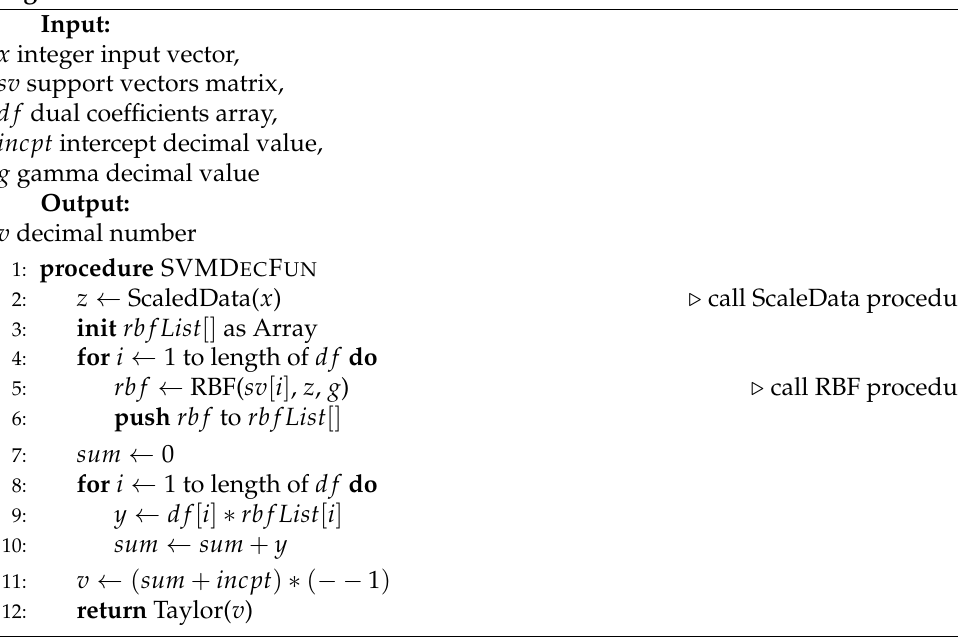
Algorithm 7 SVM decision